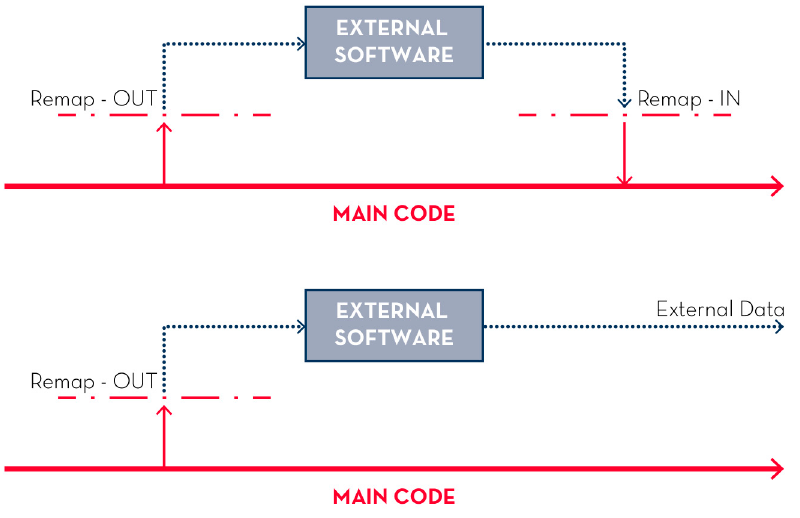
Figure 1. Schematic representation of the two data processes, the biunivocal one ( above ) and univocal one ( below ).